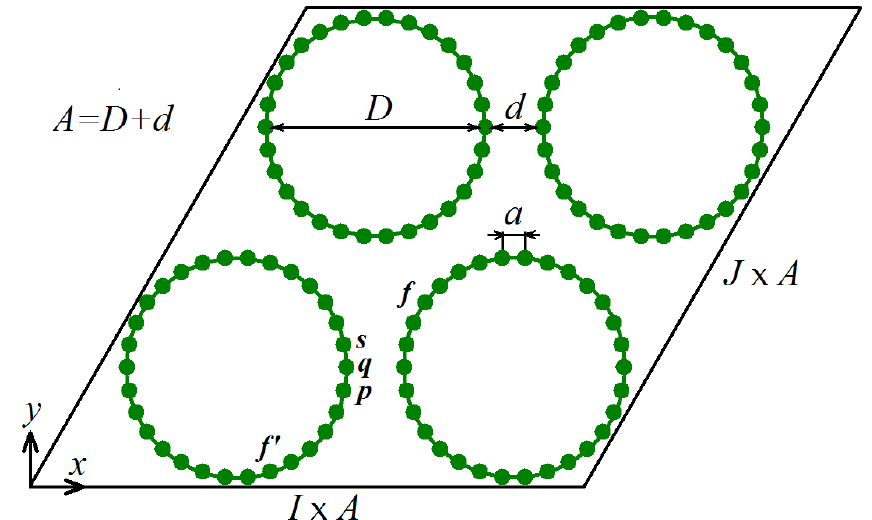
Figure 1. Geometry of the computational cell with I × J nanotubes ( I = J = 2 in this case, while I = 20, J = 24 in simulations). Each zigzag CNT is represented by 30 carbon atoms that move on the ( x , y ) plane. Each atom stands for a row of atoms oriented normal to the ( x , y ) plane, which moves as a rigid body. Geometry parameters are as follows: a is the distance between carbon atoms in the CNT wall, d is the distance between the walls of neighboring CNTs, D is CNT diameter and A = D + d is the distance between centers of neighboring CNTs. The computational cell in the form of a parallelogram has the sides I × A and J × A . The computational cell is subject to the periodic boundary